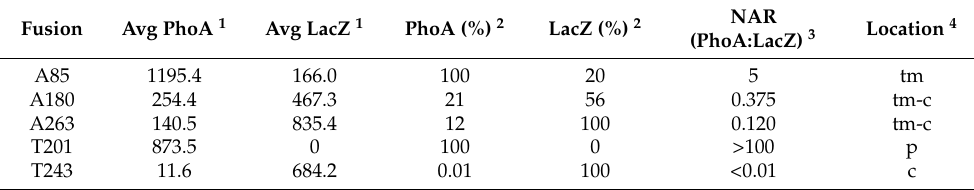
Table 1. Calculation of normalized PhoA:LacZ activity ratio (NAR) and proposed truncation sites location in a given